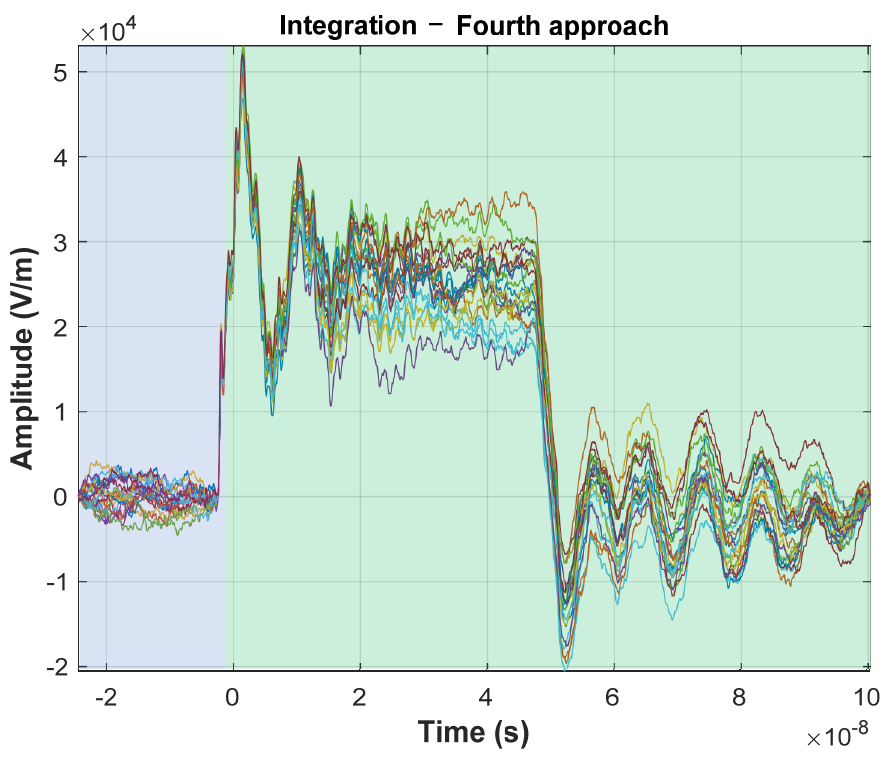
Figure 9. Integrated signal with mean value computed and subtracted from pre-trigger and post- trigger portions of signal (colored regions in the picture).